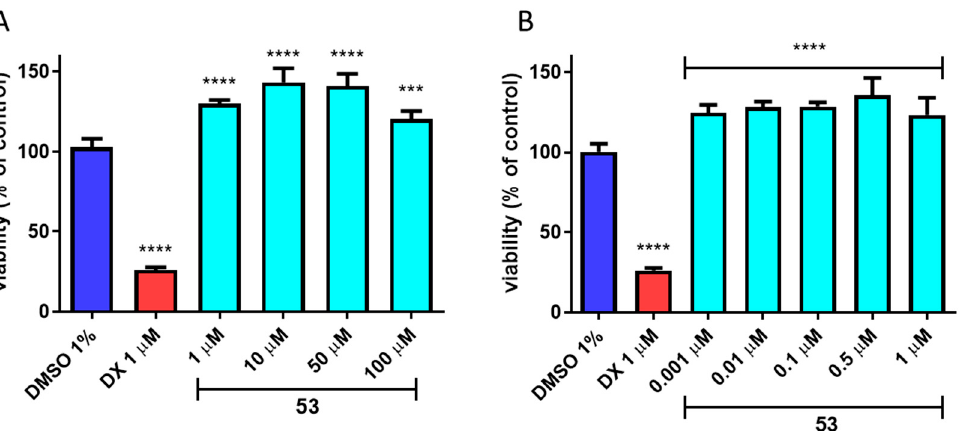
Figure 7. The effect of 53 , 60 , and 62 , cytostatic drug doxorubicin (DX) and the mitochondrial toxin CCCP on the hepatoma HepG2 cell line viability after 72 h of incubation at 37 °C, 5% CO 2 . The data were analyzed with one-way ANOVA, followed by Bonferroni’s Comparison Test (Graph Pad Prism 8.0.1 software, San Diego, CA, USA)): ** p < 0.01, **** p < 0.0001 vs. negative control (DMSO 1% in growth media).